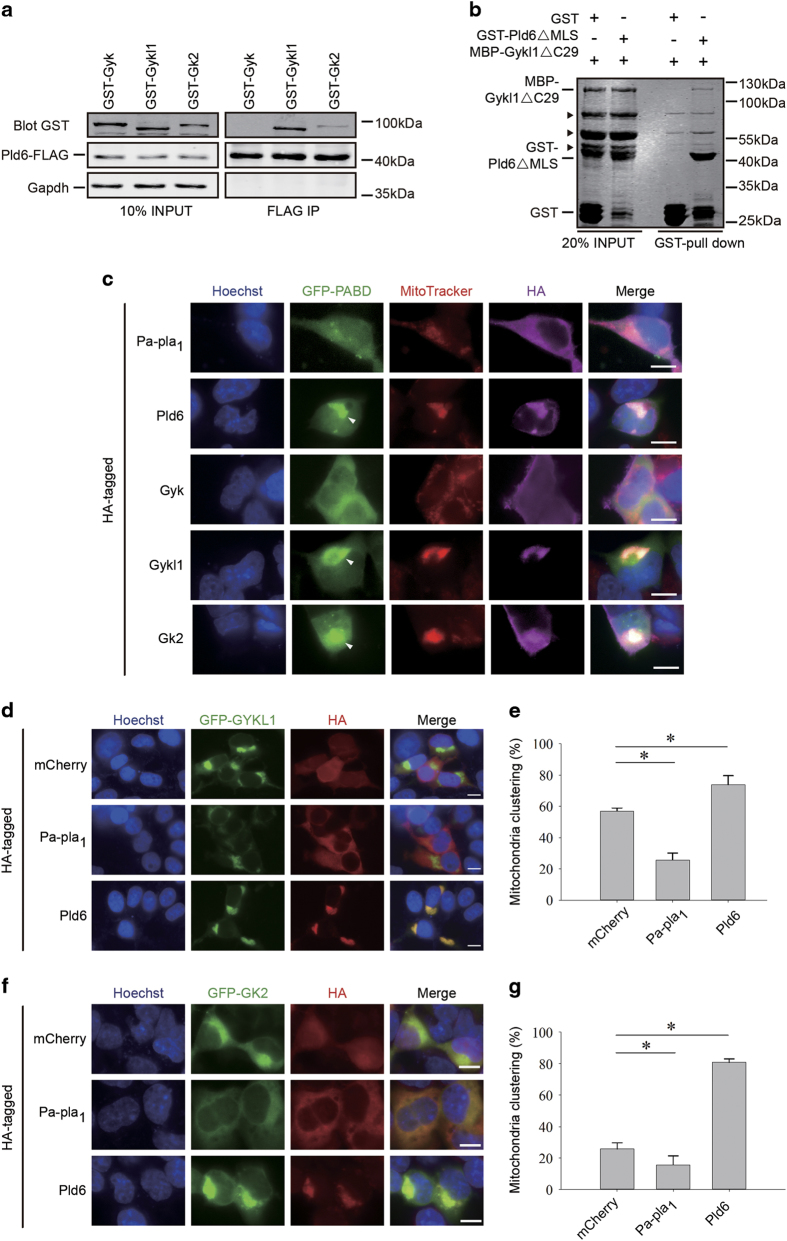
Gykl1/Gk2 interacts with Pld6 and stimulate mitochondrial clustering. (a) HEK293T cells transiently co-expressing FLAG-tagged Pld6 with GST-tagged Gyk, Gykl1 or Gk2 were immunoprecipitated (IP) with anti-FLAG antibodies. The immunoprecipitates were blotted with antibodies against GST or FLAG. An antibody against GAPDH was used for loading control. (b) Bacterially-purified GST-tagged recombinant Pld6 lacking the mitochondria localization sequence (GST-Pld6ΔMLS), was mixed with purified MBP-tagged recombinant Gykl1 lacking the C-terminal 29 amino acids (MBP-Gykl1ΔC29) for in vitro GST pull-down assays. The reaction mixtures were resolved by SDS-PAGE and stained with Coomassie blue. Recombinant GST alone served as a negative control. (c) HEK293T cells transiently co-expressing GFP-PABD with HA-tagged Pa-pla1, Pld6, Gyk, Gykl1 or Gk2 were stained with an anti-HA antibody and the MitoTracker dye. Hoechst 33342 was used to visualize the nuclei. PABD is the Raf1 Phosphatidic Acid Binding Domain. Arrows indicate areas of mitochondrial clustering. Scale bar, 10 μm. (d) HEK293T cells transiently co-expressing GFP-Gykl1 with HA-tagged mCherry, Pld6 or Pa-pla1 were immunostained with an anti-HA antibody. Hoechst 33342 was used to visualize the nuclei. Scale bar, 10 μm. (e) Cells from d were scored for cells with obvious mitochondrial clustering in three independent experiments (n=3) and the percentages of cells with mitochondrial clustering are plotted here. At least 200 cells were counted for each group. Error bars represent s.d. Statistical significance was determined by ANOVA; *P<0.05. (f and g) HEK293T cells co-expressing GFP-Gk2 with HA-tagged mCherry, Pld6, or Pa-pla1 were similarly examined (f) and analyzed (g) as described in d and e. At least three independent experiments were performed with >200 cells counted in each group. *P<0.05. Scale bar, 10 μm.